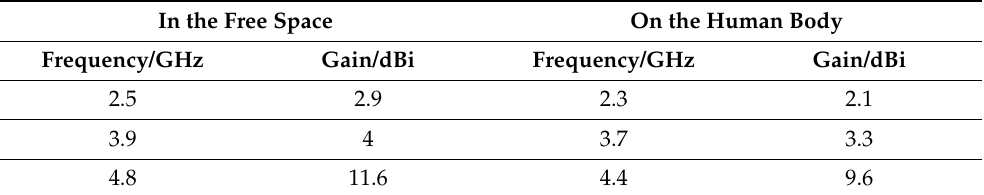
Table 3. Comparison between antenna results at two different antenna environments.